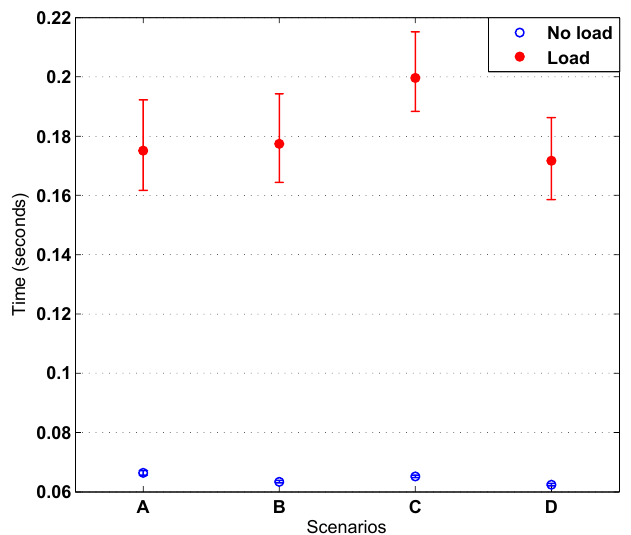
Figure 17. Integration of all ITN interaction response time